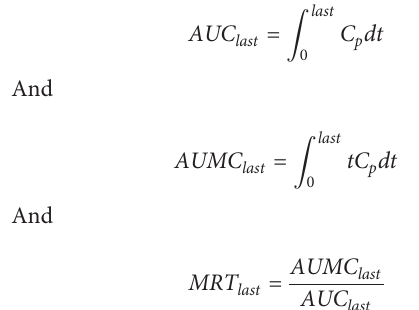
TABLE 1 | The information of primary and secondary antibodies used in mIHC detection. Primary antibodies (Dilution ratio) Secondary antibodies (Fluorophore-conjugated tyramide molecules) Rabbit anti-human CD3 antibody (1:100 dilution) (SP162, Abcam, Cambridge, UK) Rabbit anti-human CD4 antibody (1:100 dilution) (EPR6855, Abcam, Cambridge, UK) mouse anti-human CD8 a antibody (1:100 dilution) (70306s, Cell Signaling Technology) Rabbit anti-human CD31 antibody (1:200 dilution) (92841s, Cell Signaling Technology) Fluorophore-conjugated tyramide molecules served as the substrate for